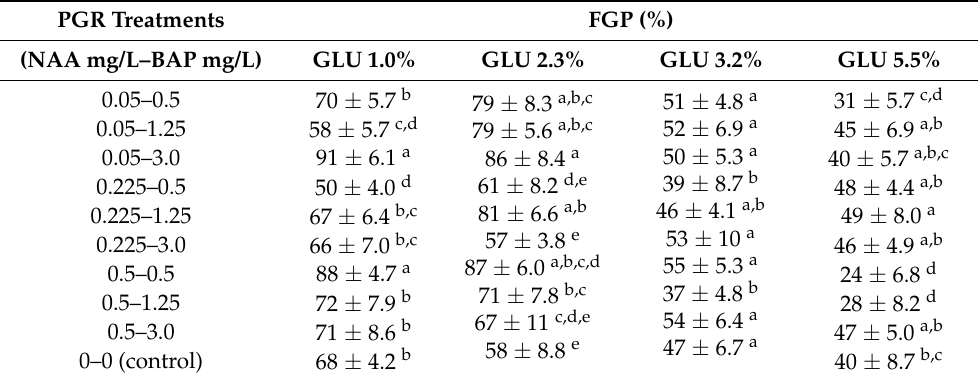
Table 2. Final germination percent (FGP) of Taraxacum officinale seeds at different concentration of glucose (GLU) and PGRs treatments. Medium supplemented with NAA and BAP (in combinations) at 18 ◦ C and photoperiod 18/6 h light/dark.